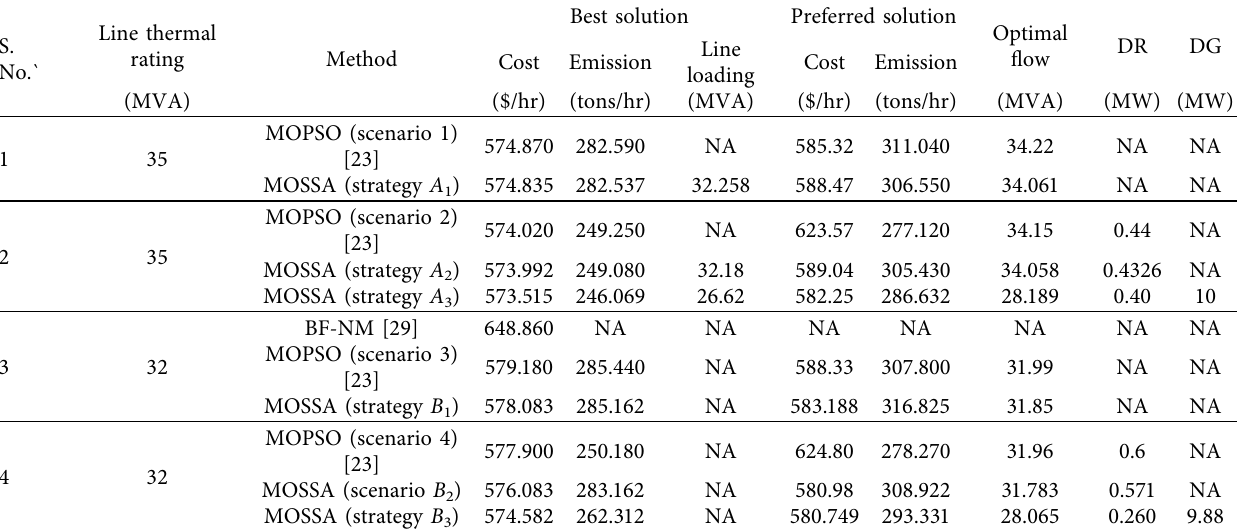
Table 14: Result comparison between proposed approach and reported methods [23,